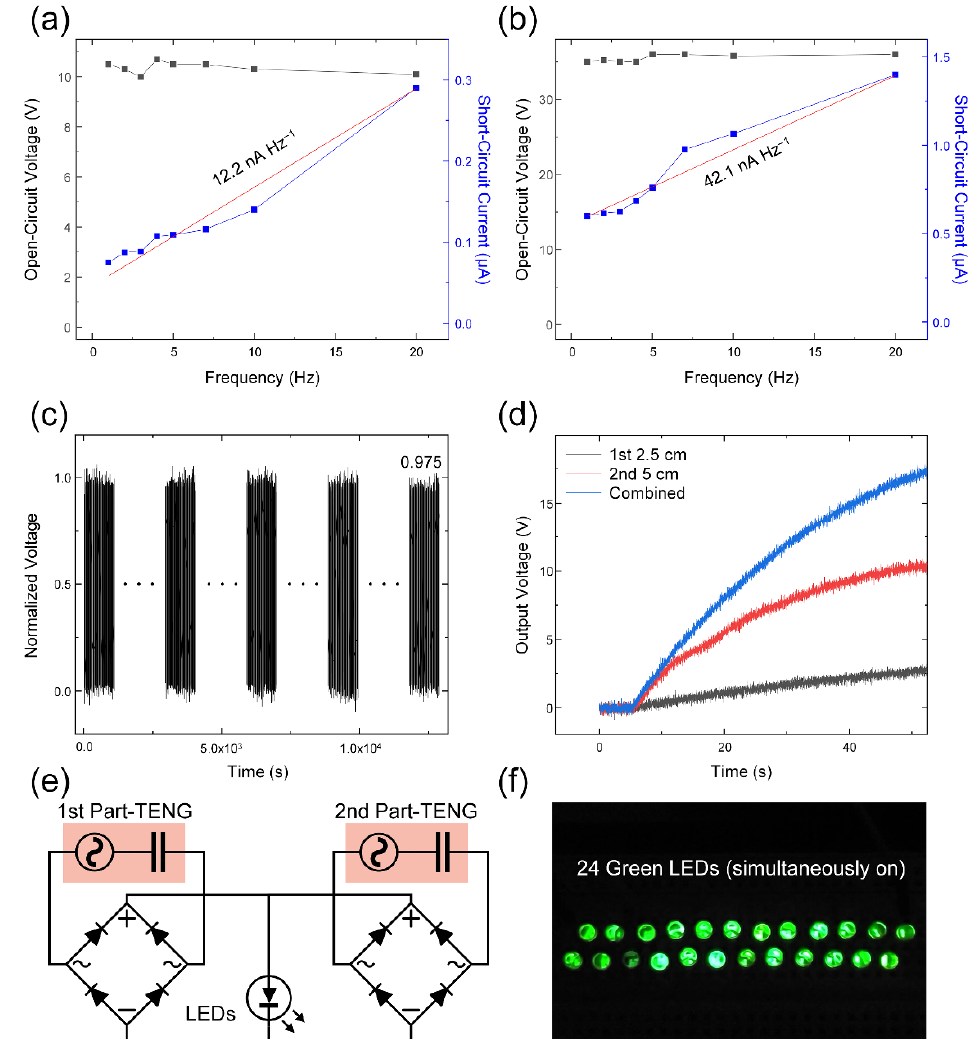
Figure 4. Additional electrical output characteristics of the fabricated L-TENG. Frequency response with the ( a ) 1st part- and ( b ) 2nd part-TENGs. ( c ) Durability test of the 2nd part-TENG with 2 Hz-input. ( d ) Charging ability to 0.1 µF capacitor with single and both L-TENG devices. ( e ) The circuit diagram for illuminating LEDs with the 1st part- and 2nd part-TENGs. ( f ) Illumination of the 24 green LEDs with the circuit composition of ( e ).